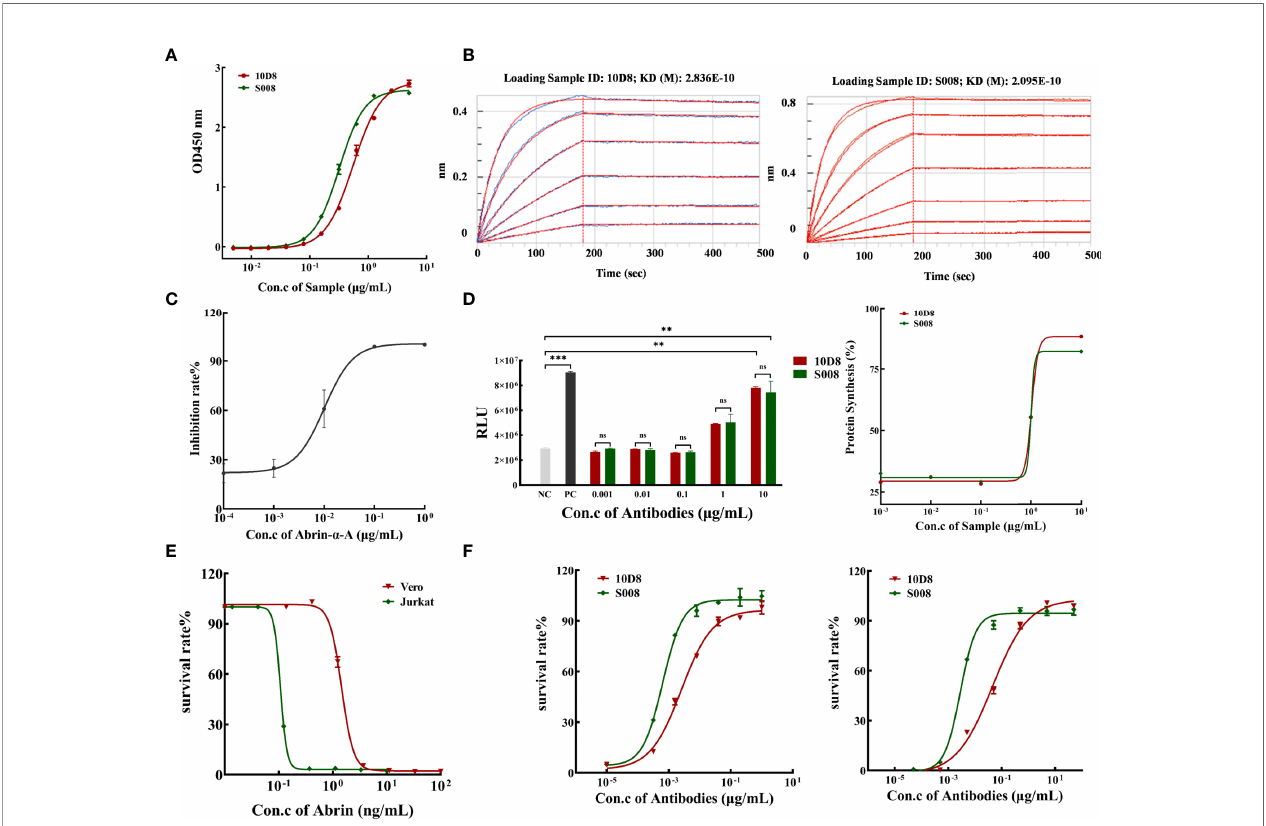
FIGURE 2 | Binding and neutralizing activity of humanized anti-Abrin antibody S008. (A) S008 binds to abrin in a dose-dependent manner determined by ELISA. Absorbance values for different antibody concentrations (0.005 to 5 m g/mL) were detected at 450 nm. The EC50 value of S008 was 0.317 m g/mL, while that of 10D8 was 0.553 m g/mL, and EC50 values were calculated using GraphPad Prism ’ s Nonliner regression (curve fi t) of XY analyses; (B) Kinetic analysis of antibody binding to abrin measured by the ForteBio method. Left: 10D8 (KD=0.2836 nmol/L); right: S008 (KD=0.2095 nmol/L). (C) Inhibition rate of protein synthesis induced by diluted recombinant abrin A chain treatment. The IC50 of protein synthesis in vitro was determined to be 0.01 m g/mL; (D) S008 and 10D8 neutralized the A chain and recovered protein synthesis in a dose-dependent manner. Left: luminescence values of 10D8 and S008. Positive control without abrin A chain, negative control without antibodies. (** P < 0.01, *** P < 0.001; ns, no signi fi cance). Right: Rates of protein synthesis by 10D8 and S008 were calculated using the equation (RLU of the experimental group)/(RLU of positive control group) ×100%. (E) Effect of different concentration of abrin on cell death. (F) S008 protected both Jurkat (left) and Vero (right) cells against abrin toxicity in a dose-dependent